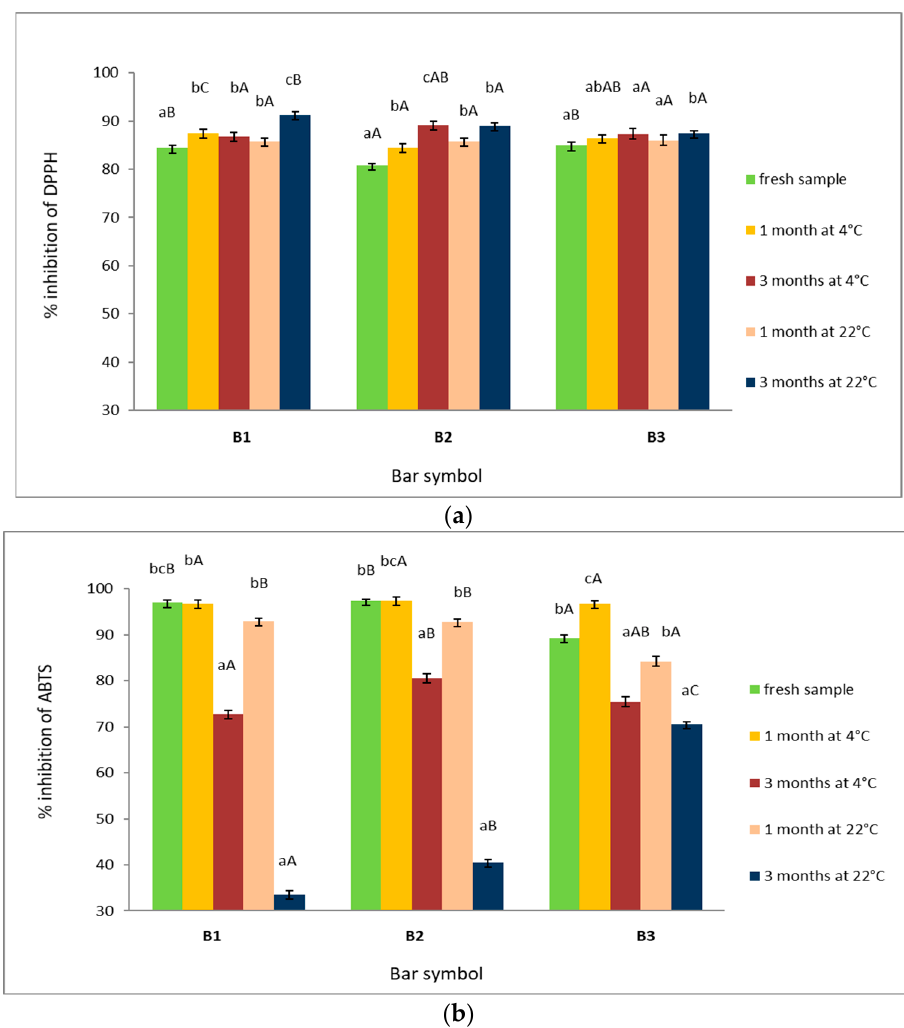
Figure 3. Antioxidant activity of organic protein bars stored at different temperature conditions ( a ) (% inhibition of DPPH) ( b ) (% inhibition of ABTS) during 1 week and 3 weeks.